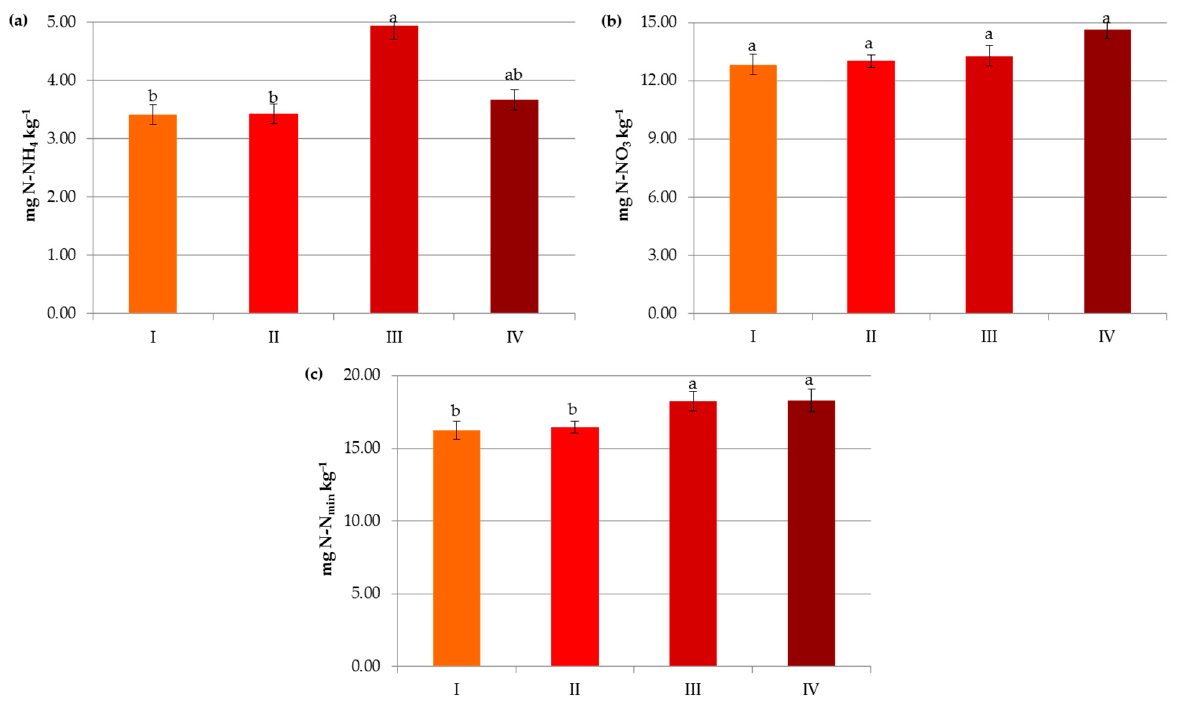
Figure 9. Impact of carbon level on contents of ammonium nitrogen ( a ), nitrate nitrogen ( b ) and mineral nitrogen ( c ): I—<1% C (very low), II—1–2% C (low), III—3–6% C (medium), IV—>6% C (high). The same letter means not significantly different.